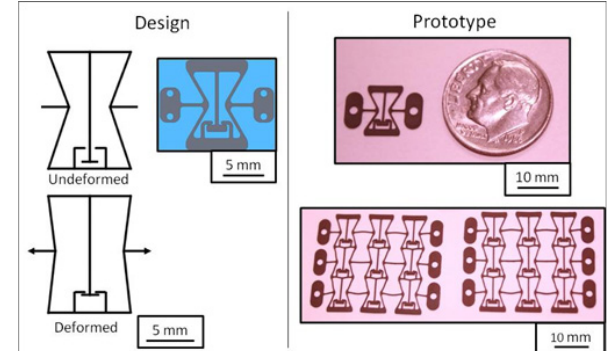
Figure 5. (Left) The design of the compliant forceps device is shown. The forceps is actuated via a sheath, a grasping action is ob- tained via moving the sheath forward, forcing the arms toward one another. (Right) Stainless steel prototype forceps are shown in an optical image, as fabricated by the LM-RIF process. The actuation of the forceps is shown in both the open and closed positions. Addi- tionally, zirconia ceramic forceps are shown in a scanning electron micrograph, as fabricated by the LM-RIF process. The stainless steel and zirconia forceps demonstrate the ability of the LM-RIF process to fabricate prototype compliant mechanisms from multiple materials.